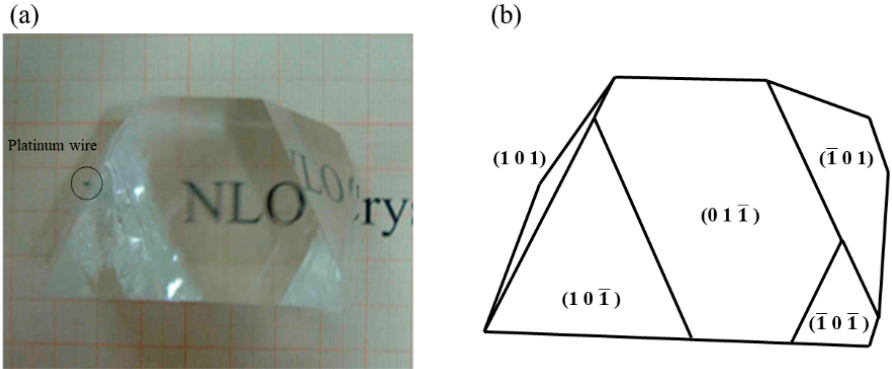
Figure 3. ( a ) CBO crystal grown using the seed-submerged growth method and ( b ) sketched mor- phology.